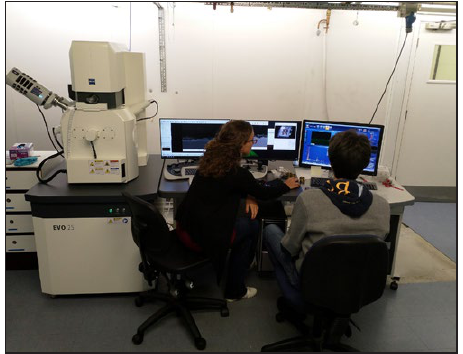
Figure 1: The new scanning electron